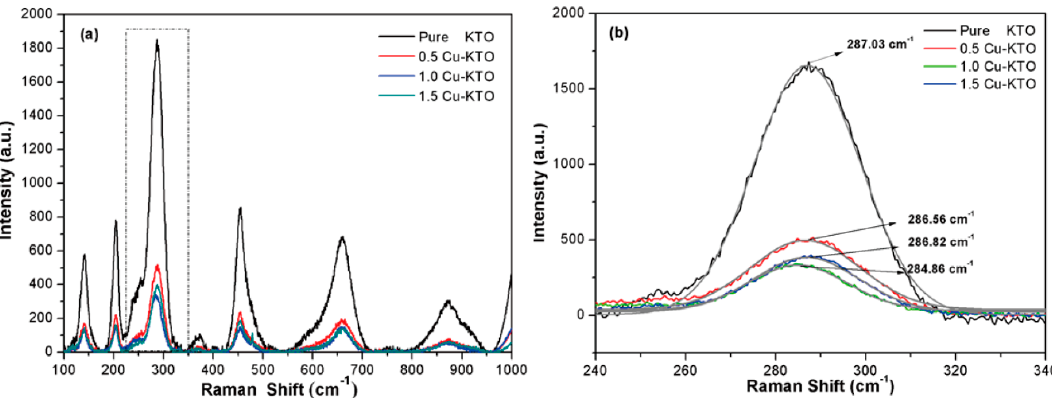
Figure 4. Raman spectra of KTO and Cu–KTO with different doping amounts ( a ) and Raman spectra of KTO and Cu–KTO samples in the range 240~340 cm − 1 ( b ).